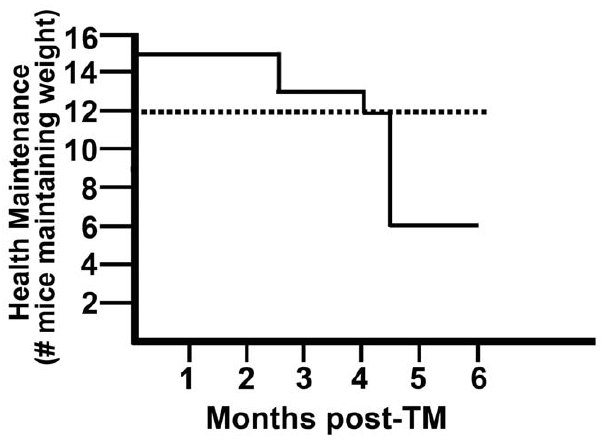
Figure 2. Morbidity analysis: epithelial expression of Kras G12D led to weight loss. Mice were monitored weekly for weight and other indications of overall health. Number maintaining at least 80% of highest body weight is plotted as a function of time for CK19 CreERT ; LSL- Kras G12D (solid line) and for littermates also injected with tamoxifen (dashed line). An additional 3 control mice were also injected with tamoxifen but were only followed for 3–5 months as controls for earlier timepoints and did not lose weight during that time (data not